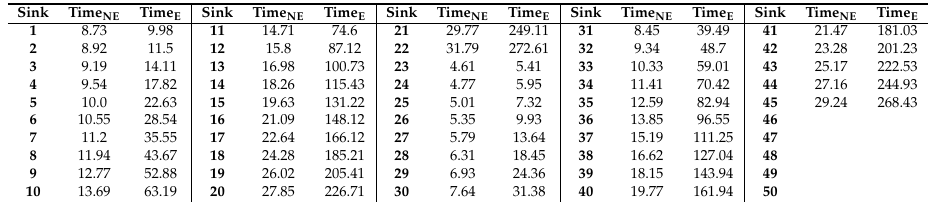
Table A11. Scenario 1: transmission times (in s) for each sink all over the transmission line. (Distance between poles is equal to 300 m, κ = 2, η = 22, η = 23, NE means no encryption, E means encryption.)